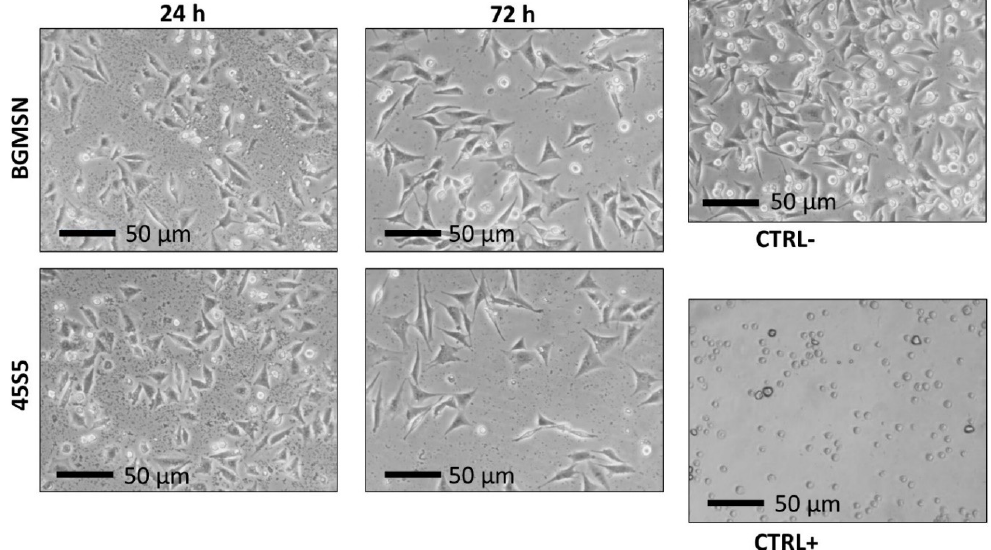
Figure 6. Morphological evaluation of murine long bone osteocyte Y4 (MLO-Y4) cells 24 h and 72 h after seeding in direct contact with sintered disks using optical microscopy (Nikon TMF, Tokyo, Japan) 50 ×